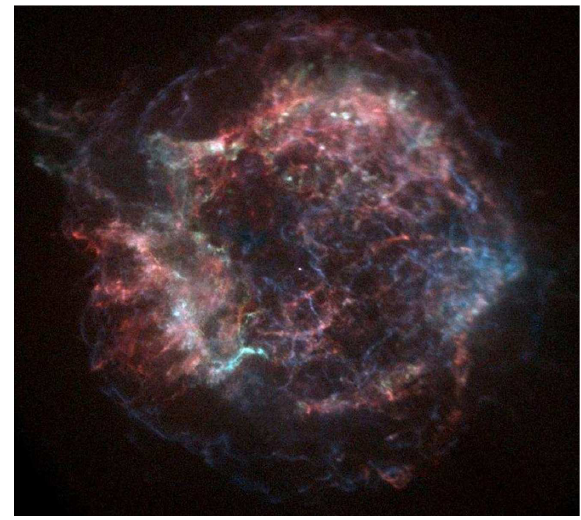
Fig. 4. An example of the data created from the event list. This Chandra X-ray Observatory image (ObsID 4638) was created by summing up all events for each image pixel observed during exposures in certain energy ranges (red – 0.5–1.6 keV, green – 1.6–2.2 keV, blue – 2.2–5.0